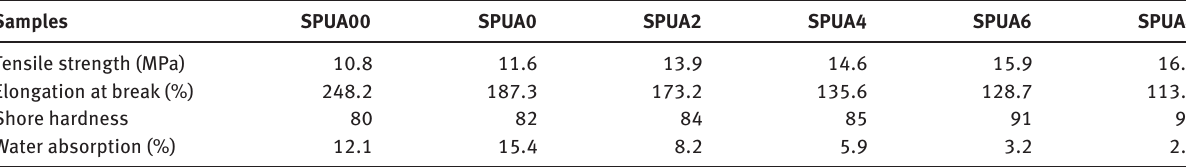
Table 2: Mechanical properties and water absorption of SPUA films with different TEOS weight %.